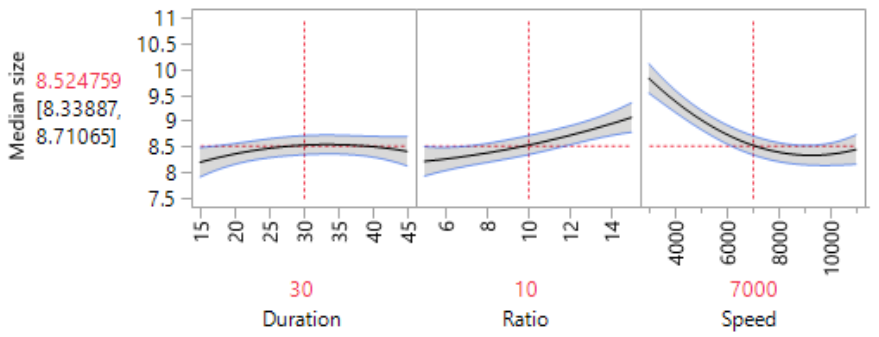
Figure 6. Predicted versus experimental responses.